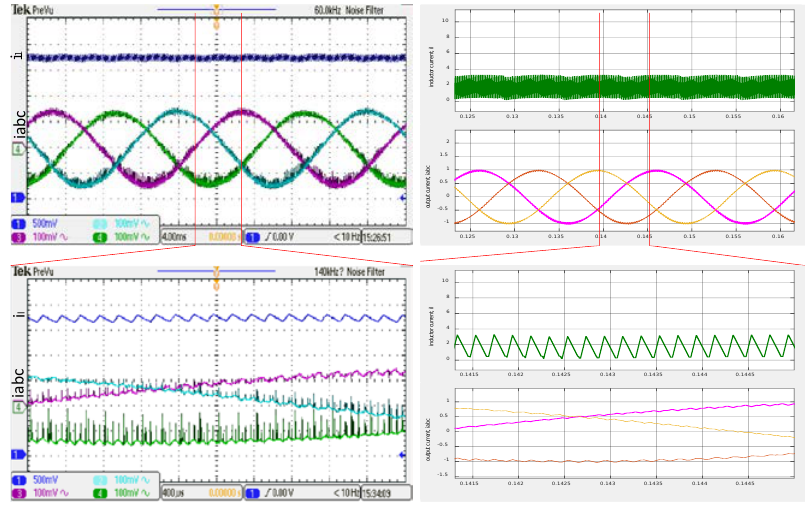
Figure 28. Inductor current and load current.